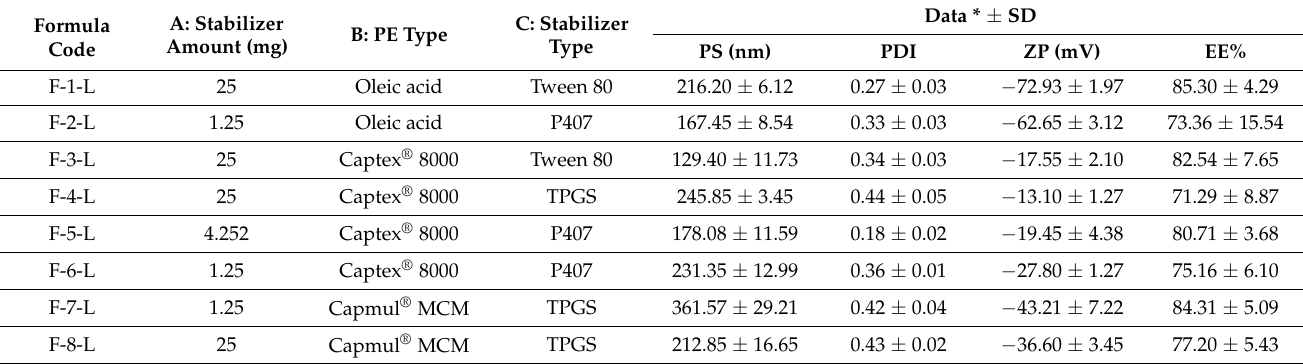
Table 4. The compositions and characterization results of TRAVO-loaded optimized